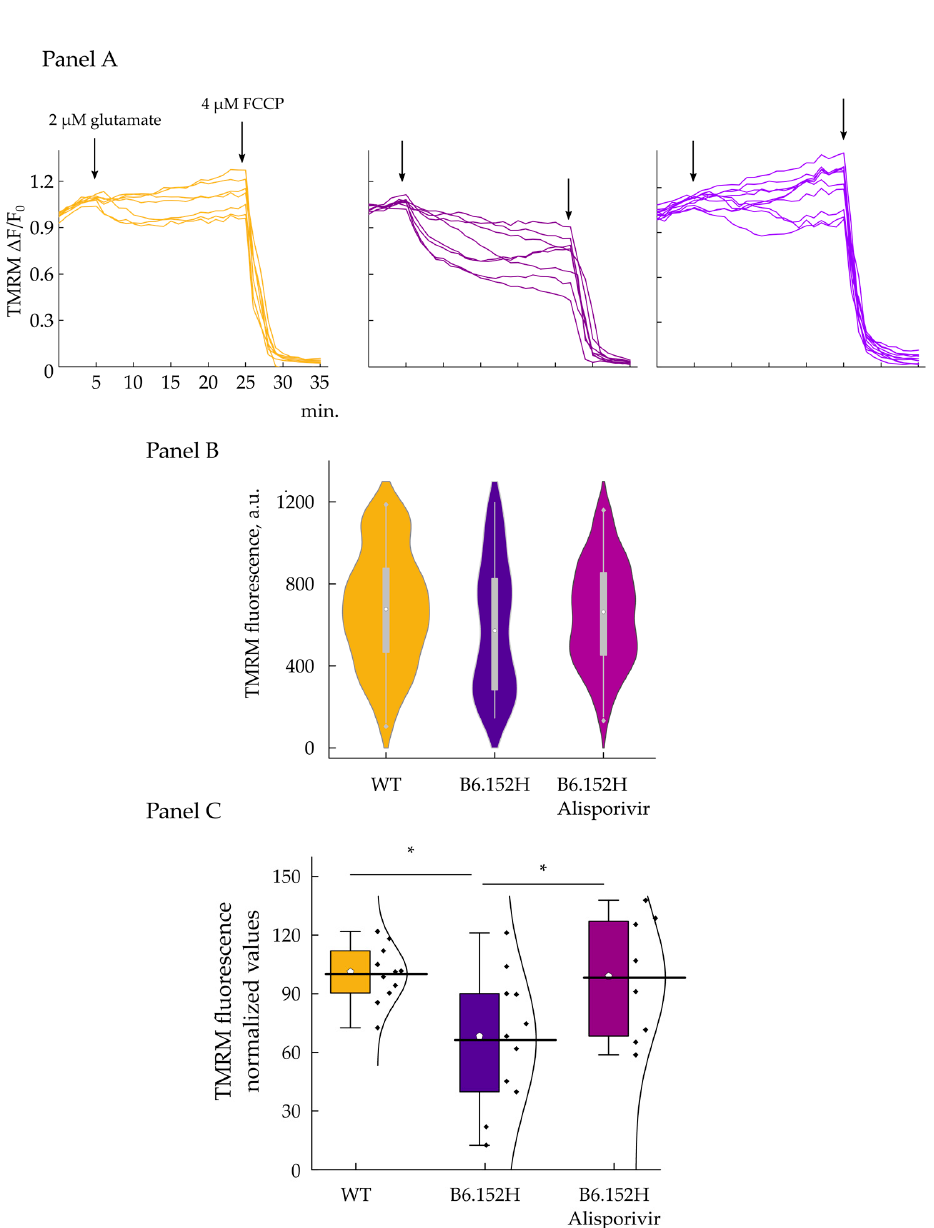
Figure 9. Effect of glutamate treatment on the mitochondrial membrane potential of primary hippocampal neurons. Panel ( A ), representative traces of WT (left), B6.152H (middle), and B6.152H cells treated with 1.5 µ M Alisporivir (right), loaded with the potentiometric probe TMRM. Where indicated 2 µ M glutamate and 4 µ M FCCP were added. Time point TMRM acquisitions are normalized to the difference between the average of initial fluorescence (first 5 min acquisitions), minus the average of fluorescence signal measured after the addition of the uncoupler FCCP (last 3 min acquisitions). Panel ( B ), violin plot, quantification of basal TMRM fluorescence expressed in arbitrary units; respectively for WT, yellow n = 167 cells; B6.152H, indigo, n = 89 cells; B6.152H plus Alisporivir, purple, n = 130 cells. ANOVA one-way test, at the 0.05 level, the population means are not significantly different. Box height, 25–75%; whiskers, 1–99%; white circle, median; transverse line, median. Panel ( C ), quantification of TMRM fluorescence 20 min after 2 µ M glutamate addition, expressed as % of initial (mean of 5 acquisitions) fluorescence. Color code as in previous panel. WT, n = 11 coverslip (157 cells); B6.152H, n = 11 coverslip (87 cells); B6.152H plus 1.5 µ M Alisporivir n = 8 coverslip (129 cells). ANOVA one-way test: α = 0.05 Tukey and Fisher test, the difference between WT and B6.152H is statistically significant, p = 0.02 as well as the difference between B6.152H and B6.152H plus Alisporivir, p = 0.048; while the difference between WT and B6.152H plus Alisporivir is not significant. * p ≤